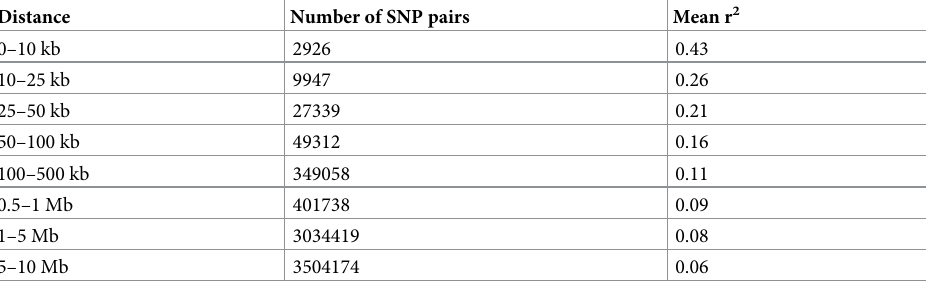
Table 3. Statistical summary of linkage disequilibrium (r 2 ) over various